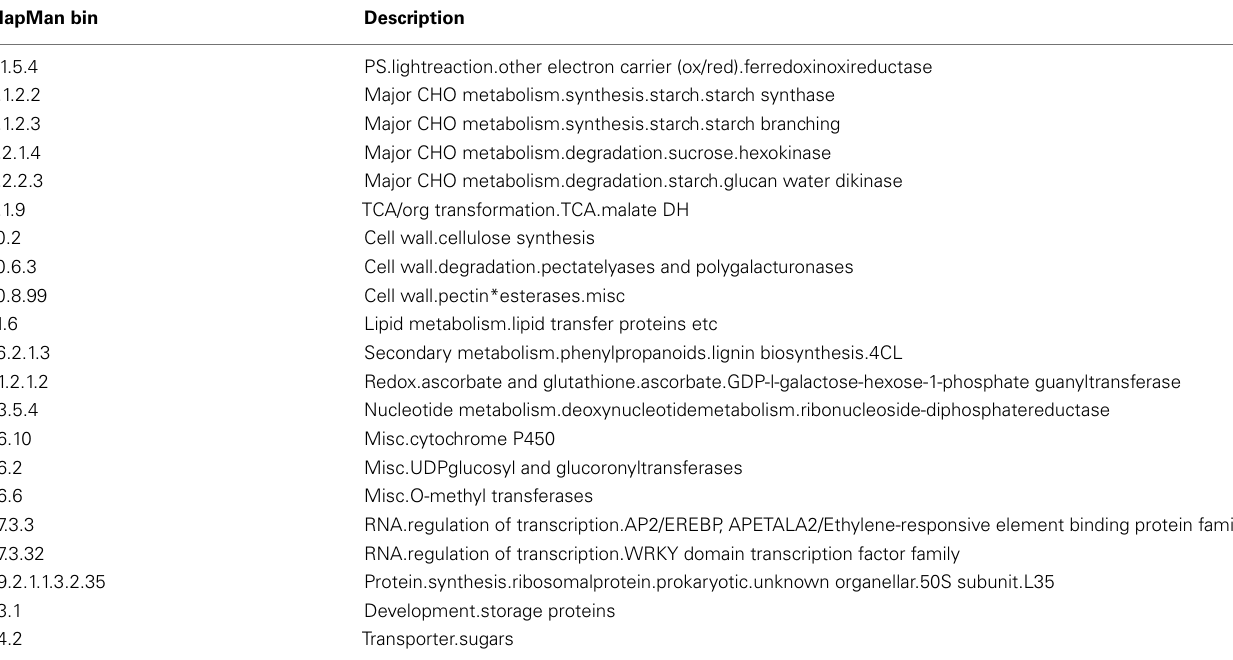
Table 2 | Overview of over-represented MapMan bins using significantly contributing observations (i.e., genes) in the STATIS analysis of the re-normalized